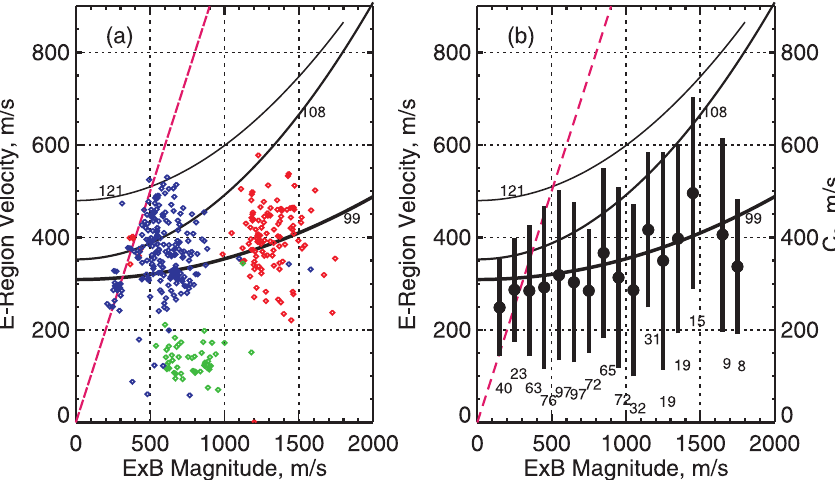
Fig. 6. (a) Scatter plot of the Stokkseyri E-region velocity in beams 1 and 2 versus E × B drift magnitude (estimated from F-region velocity data, as discussed in the text) for the events of 1 November 2001 (red), 19 November 2001 (green) and 15 January 2002 (blue). These are three typical types of events identified in the data. Shown also are curves for the dependence C S ( E × B ) at the heights of 99, 108 and 121km, reported in Fig. 1. Dashed and pink line is an ideal coincidence line. (b) Binned values of the Stokkseyri velocity in beams 1 and 2 (black dots) with standard deviation in each bin (vertical bars) and the number of values involved in averaging over each bin. The curved lines are the same as in panel (a)